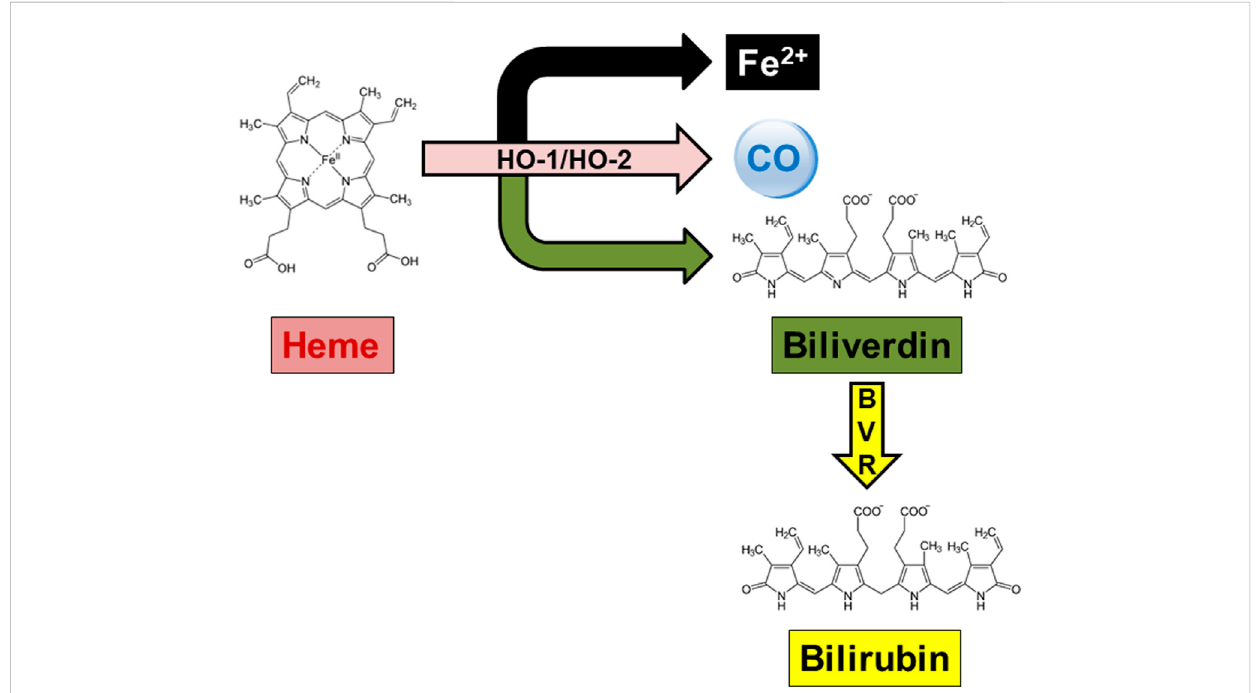
FIGURE 1 The heme metabolic pathway. In the presence of oxygen and reducing equivalents provided by the NADPH-cytochrome P-450 reductase, both hemeoxygenase(HO)-1and HO-2oxidativelycleave thehemoproteins ’ hememoietiesatthe α -meso-carbon bridge,resultinginequimolaramountsof ferrous iron (Fe 2+ ), carbon monoxide (CO) and biliverdin. Biliverdin is further reduced at the C10 ( γ bridge) by the NAD(P)H-requiring enzyme biliverdin reductase (BVR), yielding bilirubin as the fi nal product.